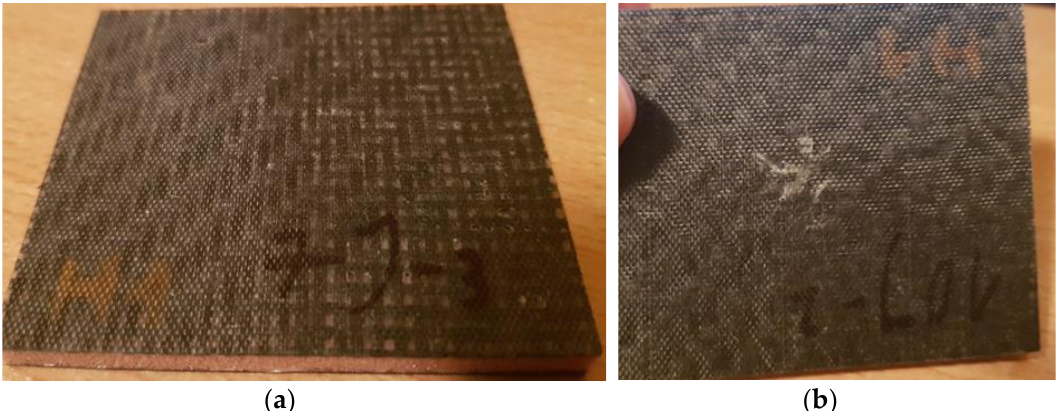
Figure 11. Opposite impact side of composite with Herex 90 core: ( a ) 7 J energy and ( b ) 10 J energy.